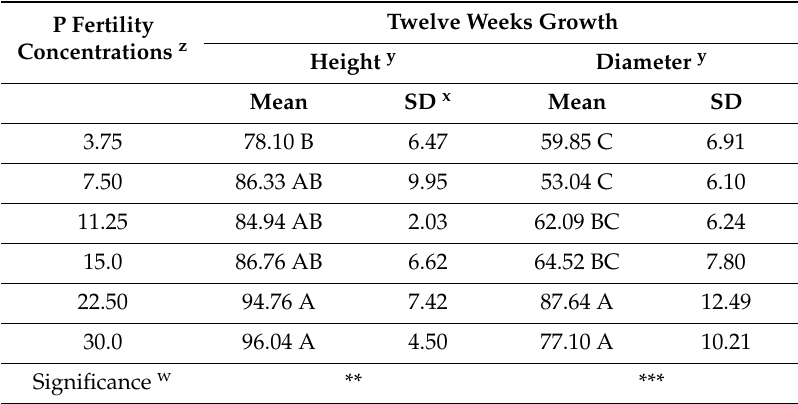
Table 5. The impacts of phosphorus (P) fertility on plant growth metrics of C. sativa “BaOx” after four weeks of the induction of the critical night length